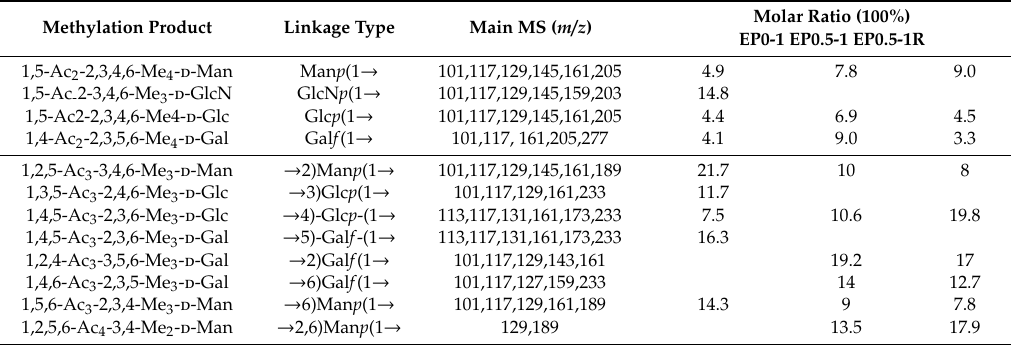
Table 2. Methylation analysis of EP0-1, EP0.5-1, EP0.5-1R. Methylation